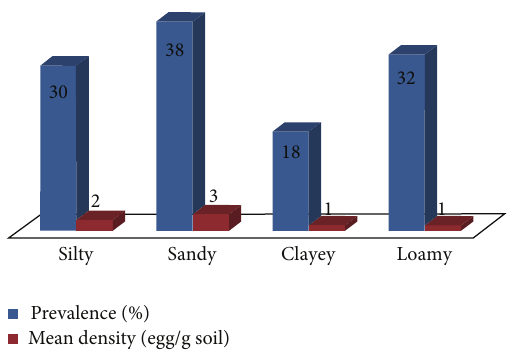
Figure 1: Prevalence (%) and mean density of soil-transmitted helminth (STH) eggs collected from soils in selected towns of Laguna, Philippines.